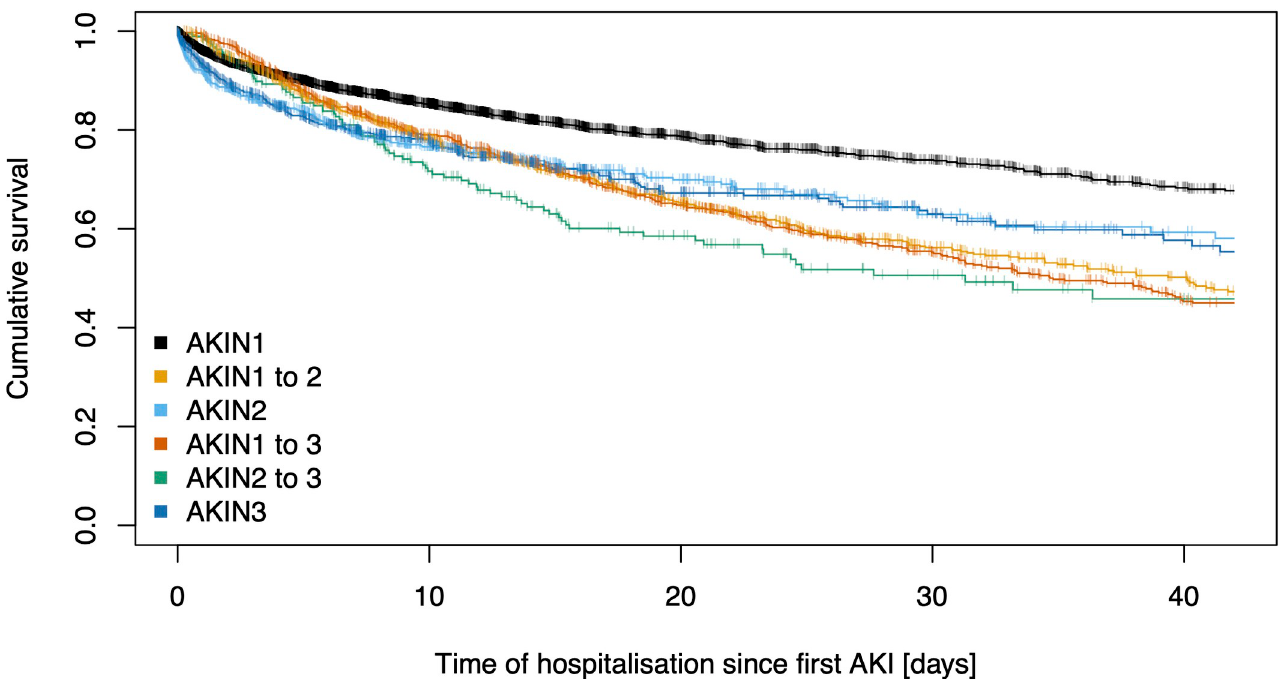
Fig 3. Survival of patients with progressive and non-progressive AKI. Kaplan-Meier curves for the first 42 days of hospitalisation after first AKI detection. Patients were divided into six groups according to first and maximum detected AKI stage, which is equal for non-progressive AKI (AKIN1, AKIN2, AKIN3) and given as AKIN X to Y (X = first and Y = max AKI stage) for progressive AKI. Censored survival data due to hospital discharge are indicated by +. Median lengths of hospitalisation were 14, 23, 15, 26, 22, 15 days for AKIN1, AKIN1 to 2, AKIN2, AKIN1 to 3, AKIN2 to 3 and AKIN3, respectively.